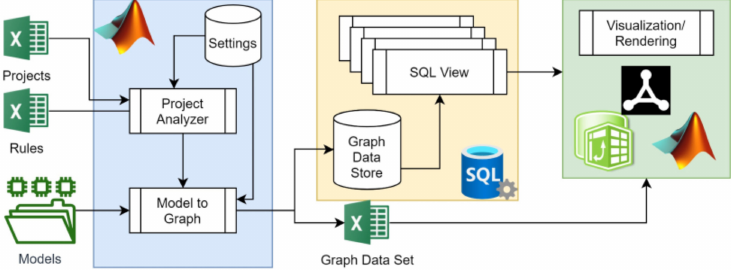
Figure 9. Model Analyzer Framework V0.1—Prototype Architecture Description